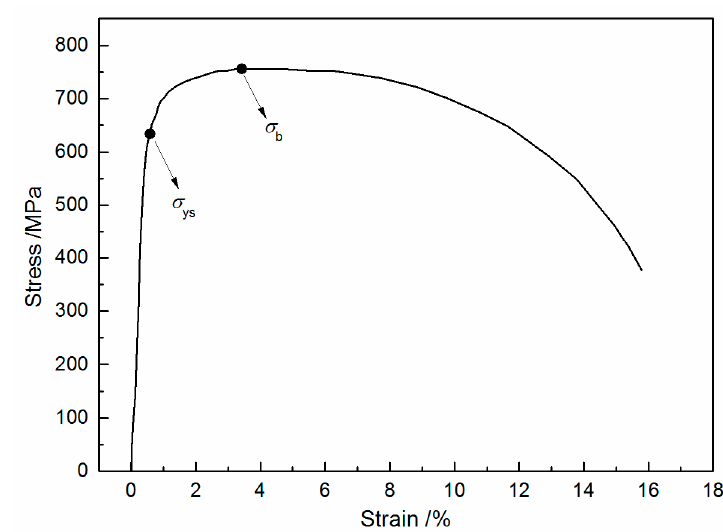
Figure 1. Stress-strain curve of X80 steel at a drawing rate of 3 mm/min in air.